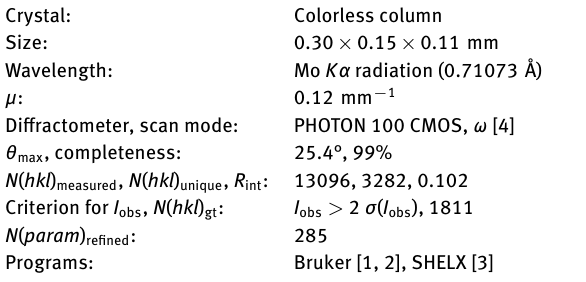
Table 2: Fractional atomic coordinates and isotropic or equivalent isotropic displacement parameters (Å 2